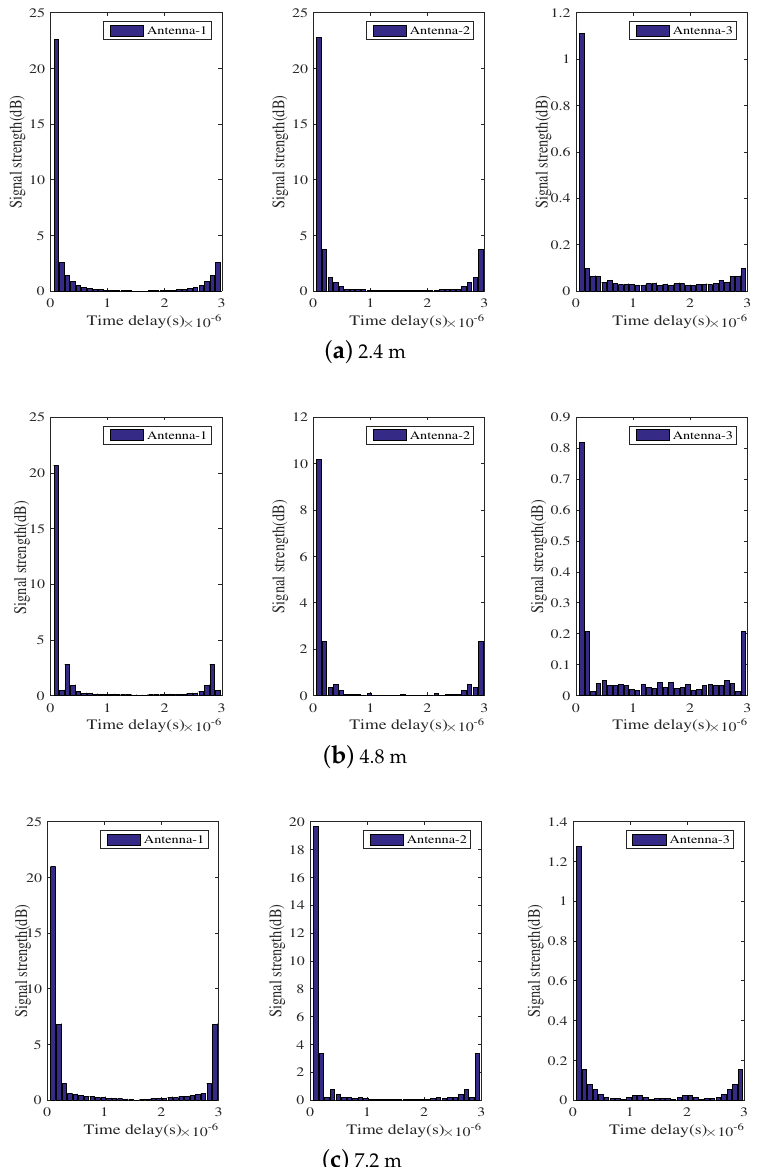
Figure 6. Time domain diagram of the indoor laboratory at different distances after filtering the time